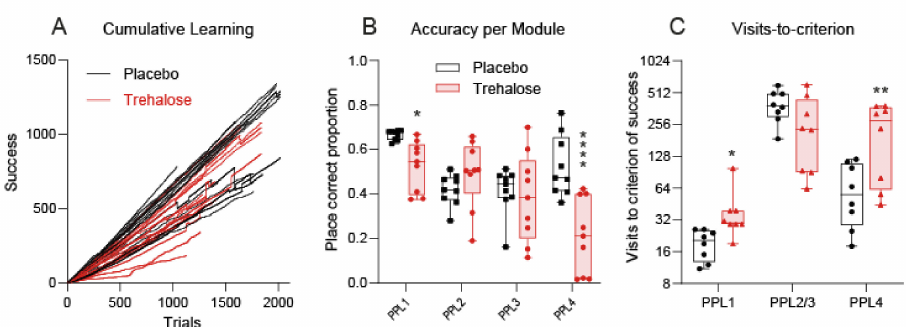
Figure 6. Learning in IntelliCage Place Preference Learning (PPL) tasks. ( A ): The XY plots shows the cumulative number of trials versus the cumulative number of successes, analyzed for each PPL period. Hence, each mouse is represented by four lines. The steepness of the learning curves is lower for trehalose-treated mice, particularly in PPL-1 and PPL-4. ( B ): Accuracy (proportion of correct visits) per learning module. ( C ): Number of trials needed to reach the criterion of success which was defined as 10% above random, i.e., 60% in PPL-1 and 35% in PPL-2, 3, and 4. PPL2/3 were analyzed together. The box shows the interquartile range, the line the median, the whiskers minimum to maximum, the scatters individual mice. Data in B and C were compared with 2-way ANOVA for “module” x “treatment” and subsequent post hoc analysis for trehalose versus vehicle, using an adjustment of alpha according to Šid á k. Asterisks show multiplicity-adjusted p -values, * < 0.05; ** < 0.01, **** <